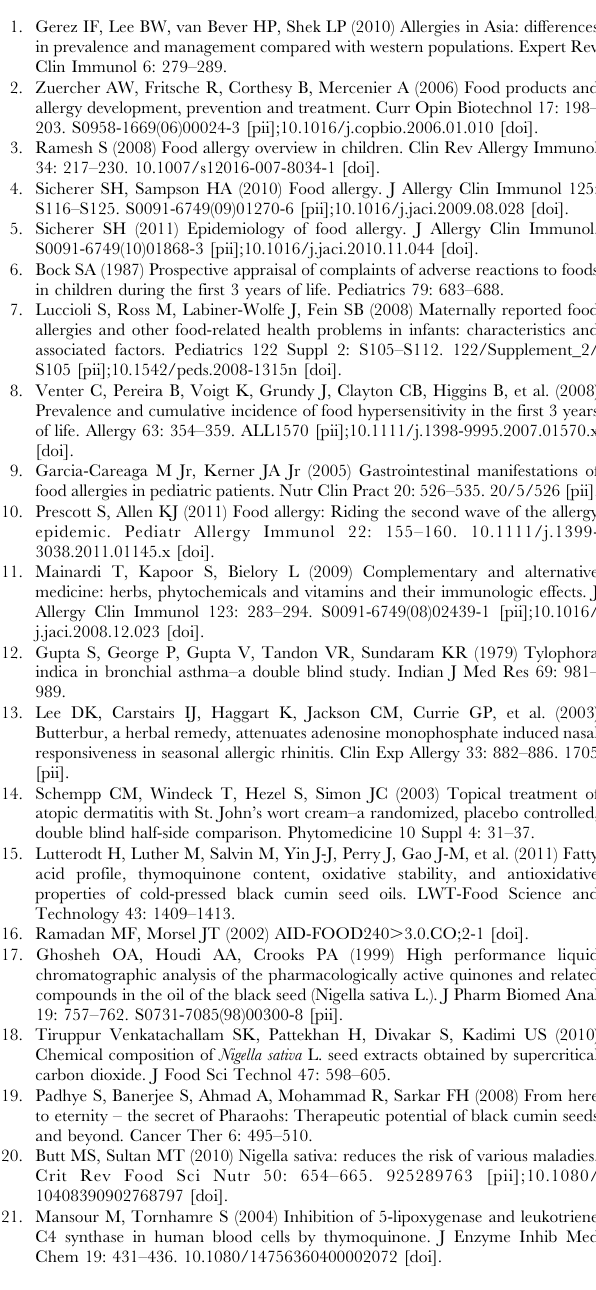
Figure S2 MOR-agonist (DAMGO) decreases IL-5 and IL-10 in OVA-allergic mice. OVA-sensitized mice were challenged with saline (Saline) or OVA (OVA) with or without pre-treatment. Panels A and B show the concentration of IL-5 ( A ) and IL-10 ( B ) in supernatant from ex vivo re-stimulated mesenteric lymphocytes of mice subcutaneously treated with 5 mg/kgBW MOR-agonist (DAMGO) and naloxone-methiodide (DAM- GO + N-M 1 mg), or naloxone methiodide alone (N-M 1 mg). Each dot represents the corresponding value for one animal and the bars represent the median and interquartile range, * p , 0.05; n =5–10.